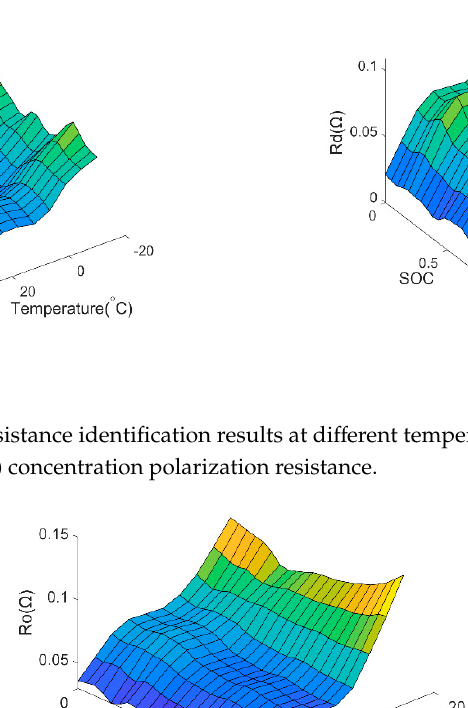
Figure 9. Polarization capacitance identification results at different temperatures: ( a ) Electrochemical polarization capacitor; ( b ) concentration polarization capacitor.